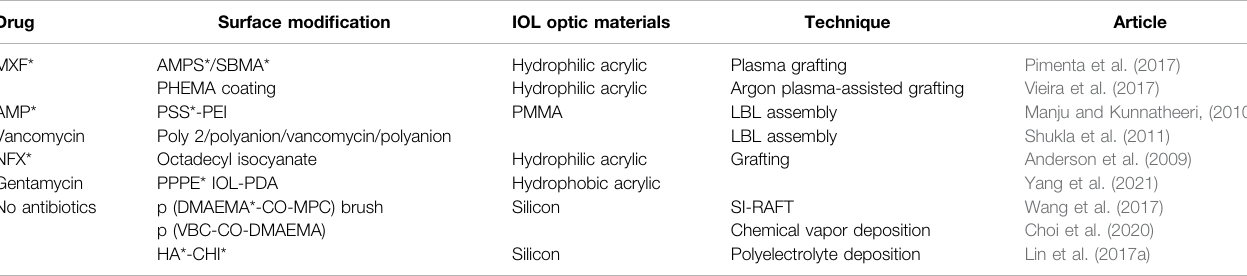
TABLE 4 | The studies on materials reducing